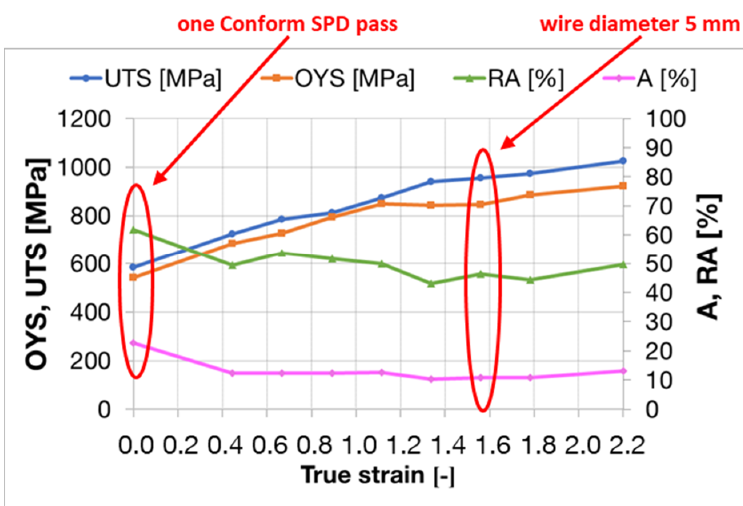
Figure 15. Results of tensile testing of titanium Grade 2 after one Conform SPD pass and rotary swaging as a function of the true strain induced by rotary swaging.